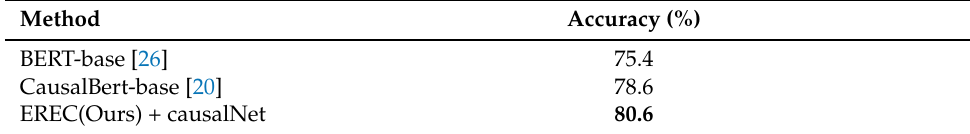
Table 1. Results on COPA-Test .